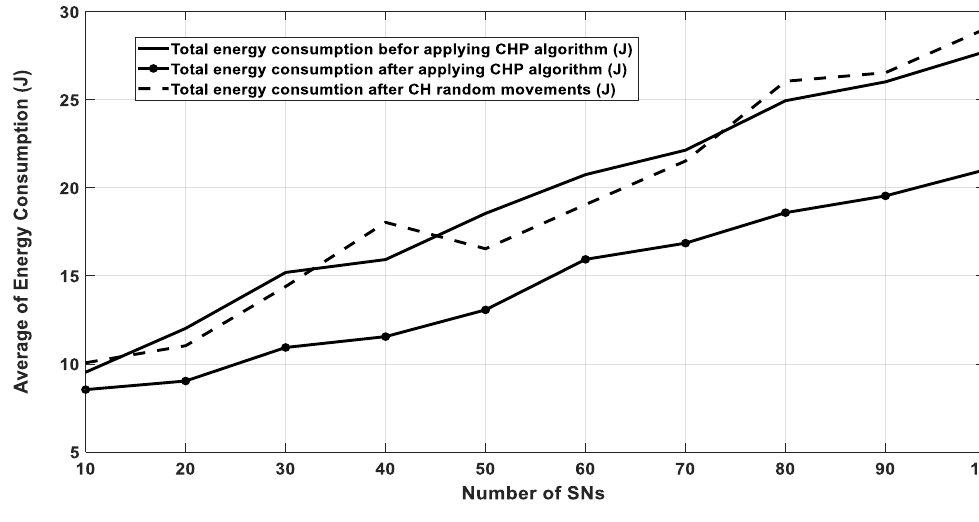
Figure 10. Energy consumption for all the SNs after 1000 rounds.